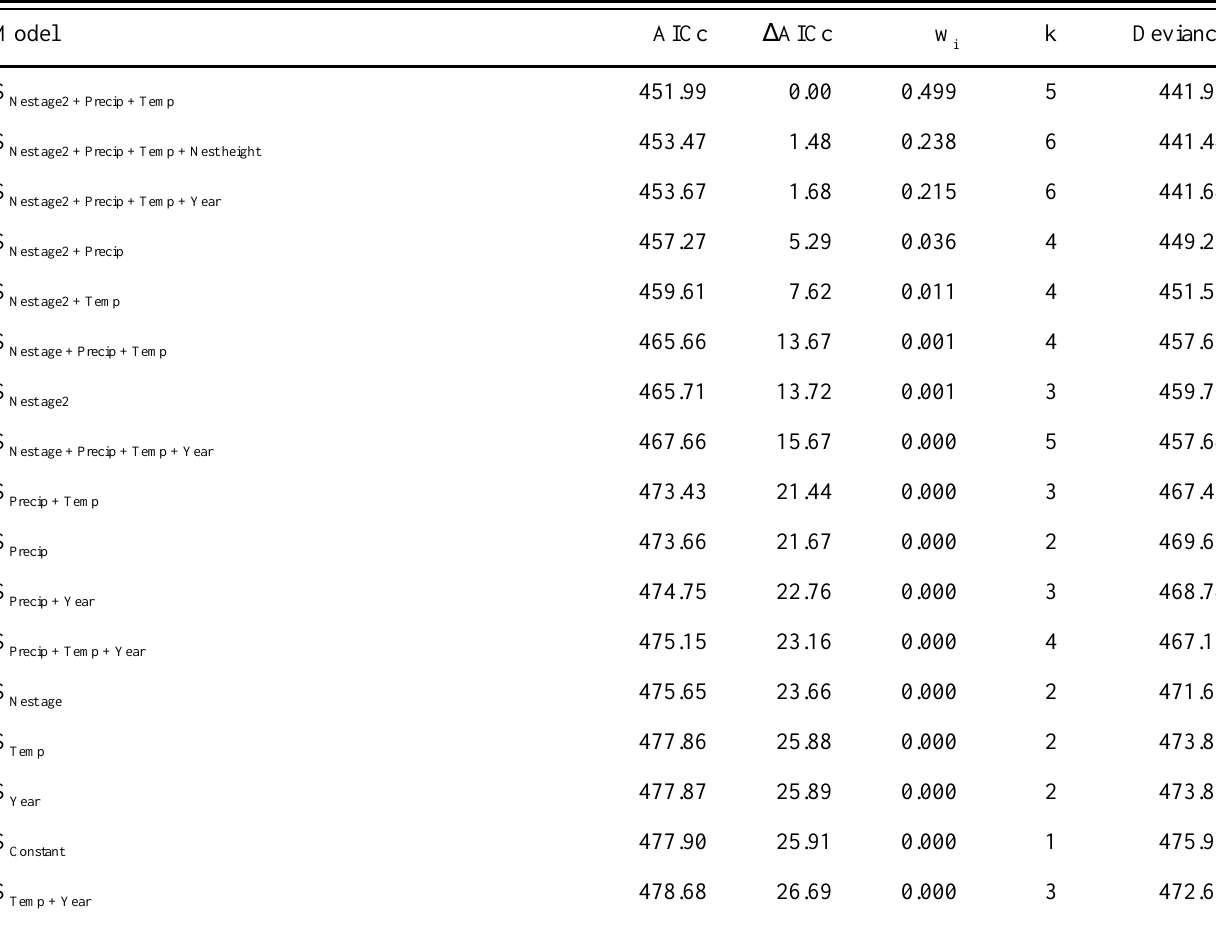
Table 1. Summary of model selection results for nest survival of Loggerhead Shrikes in southeastern Alberta in 1992 and 1993. Analyses were performed using program MARK and models are ranked by ascending Akaike’s Information Criterion for small samples (AICc). D AICc is the change in AICc between that model and the best fitting model, w is model weight (a measure of the relative likelihood of each i model) and k is the number of model parameters. Deviance is the difference in the -2*log-likelihood between that model and the saturated model. Nest age refers to the linear age model, whereas nest age2 refers to the quadratic model. Models without nest age assume constant survival across the nest cycle. Model